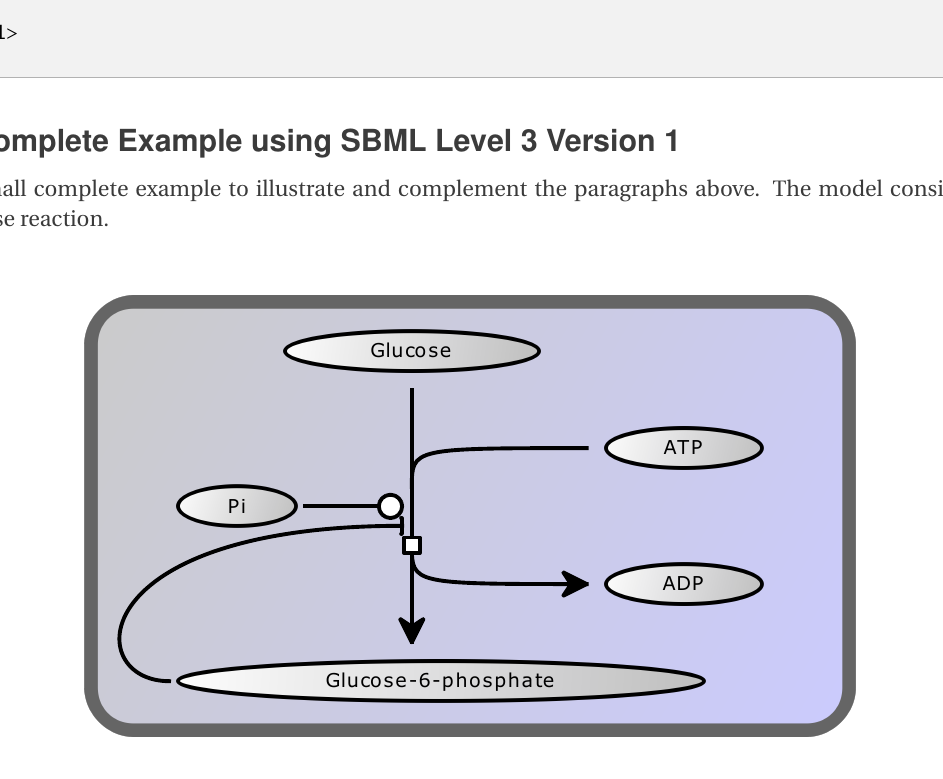
Figure 15: One possible rendering of the example